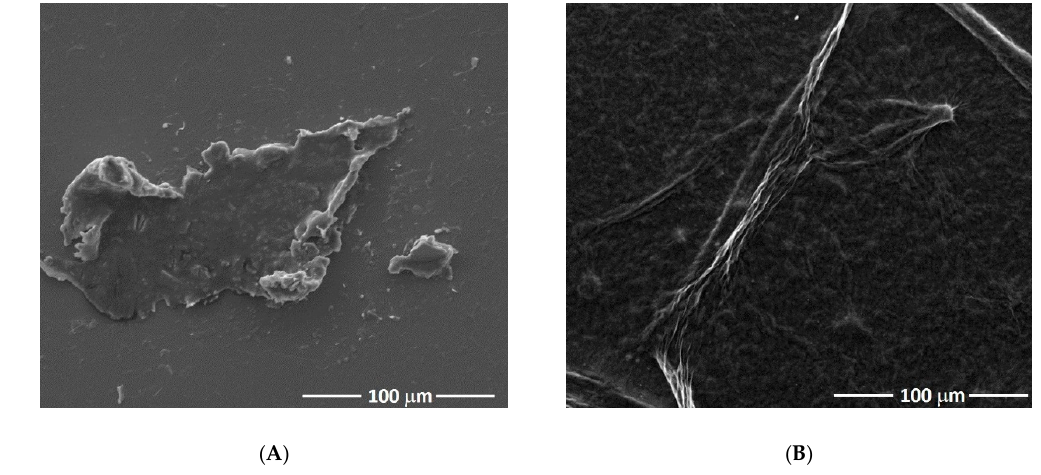
Figure 3. SEM micrographs for GO ( A ) and rGO ( B )